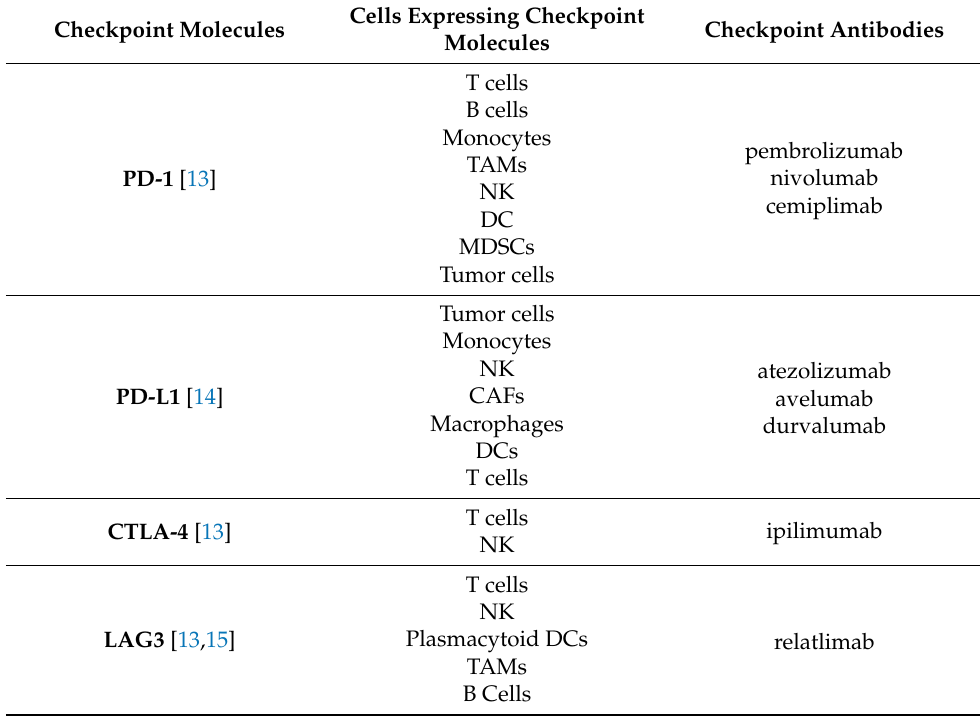
Table 1. Relevant checkpoint molecules, cells that express these checkpoint molecules, and FDA- approved antibodies for the treatment of cutaneous